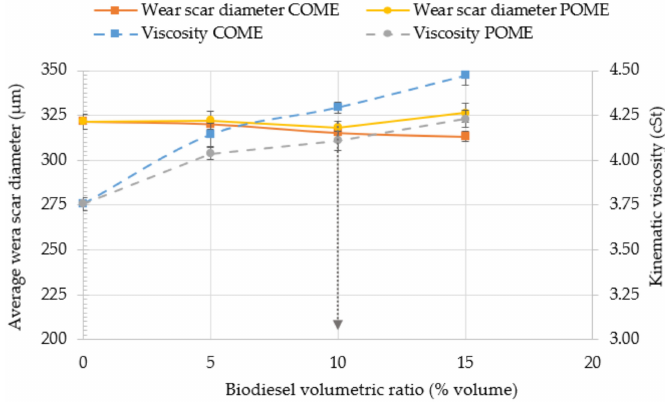
Figure 3. Lubricity and viscosity of biodiesel blending.